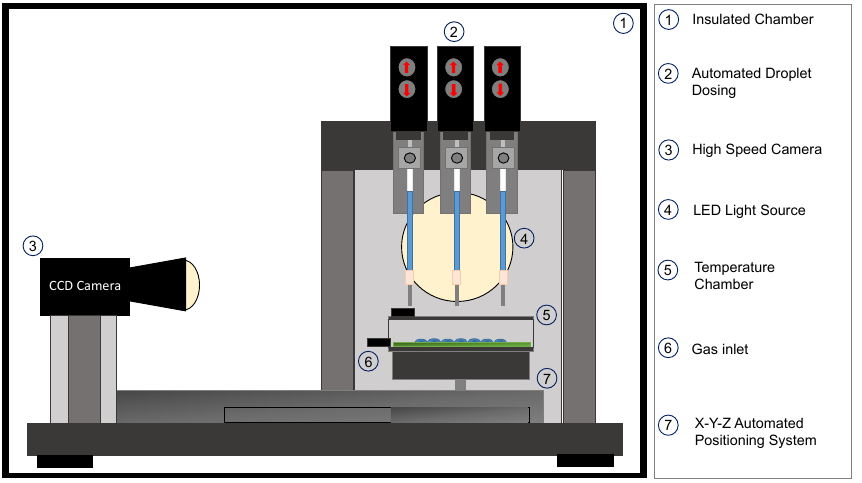
Figure 2. Schematic representation of the main components of the spray printing setup. Not shown: Data acquisition